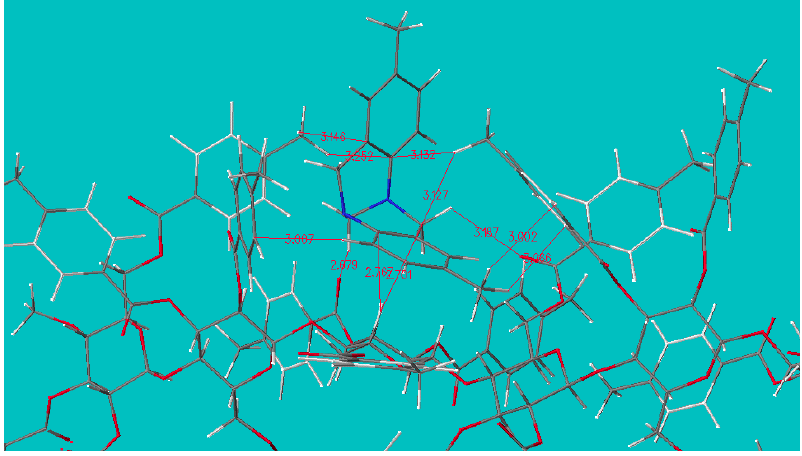
Figure 5. The predicted association of cellulose tris(4-methylbenzoate) and the more retained ( 5R, 11R )-( − )-enantiomer of Tr(cid:31)ger’s Base. Atoms close together are connected by a thin line and the atomic distance is given. The close stacking between aromatic ring and glucose ring is notable. The contribution of benzoyl methyl groups can rationalize why “OJ” can separate Tr ӧ ger’s base enantiomer but “OB” cannot, and that of the methyl group of Tr ӧ ger’s base can explain why substituting the methyl group with either hydrogen or chlorine deteriorates retention and chiral recognition [26].